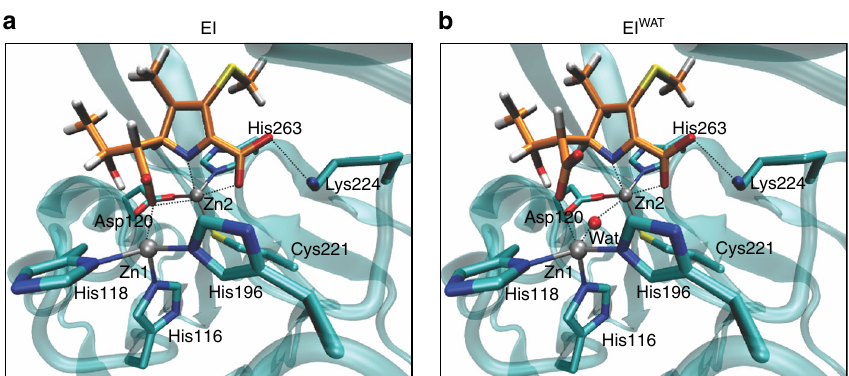
Fig. 6 Structure of the proposed intermediate species formed during the hydrolysis of carbapenems by bi-Zn(II)-M β Ls. Optimized structures of EI a and EI WAT b . The quantum protein subsystem is depicted with the conventional liquorice colours (C cyan , H white , O red , N blue , and S yellow ). Zn(II) ions are shown as grey spheres . Carbon atoms of the antibiotic derived ligand are shown in orange . Coordination bonds of the amino acid residues to Zn(II) are shown with solid lines and interactions with the antibiotic derived ligand are shown with dotted